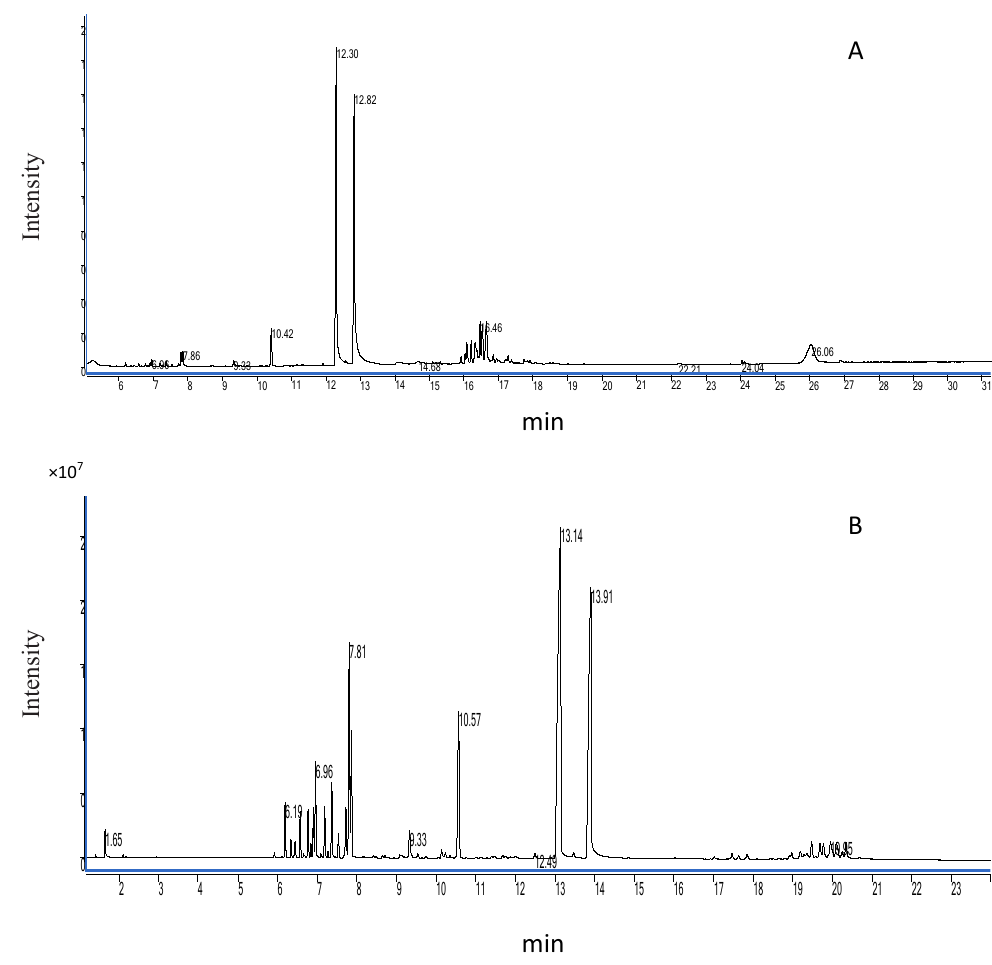
Fig 1 . GC-MS total ion chromatograms of chemical compositions (A) and volatile components (B) of L. cubeba